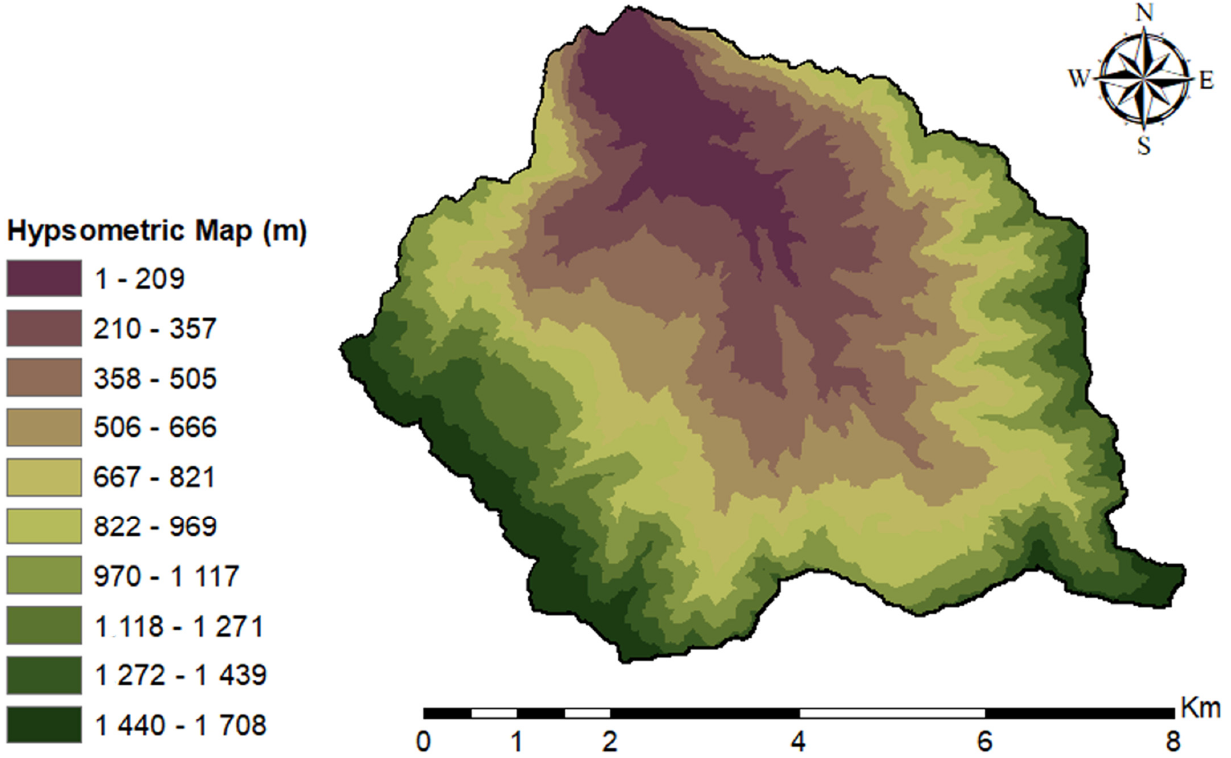
Figure 5. Hypsometric map—DEM file (Source: Authors by ESRI ArcGIS, 2020).